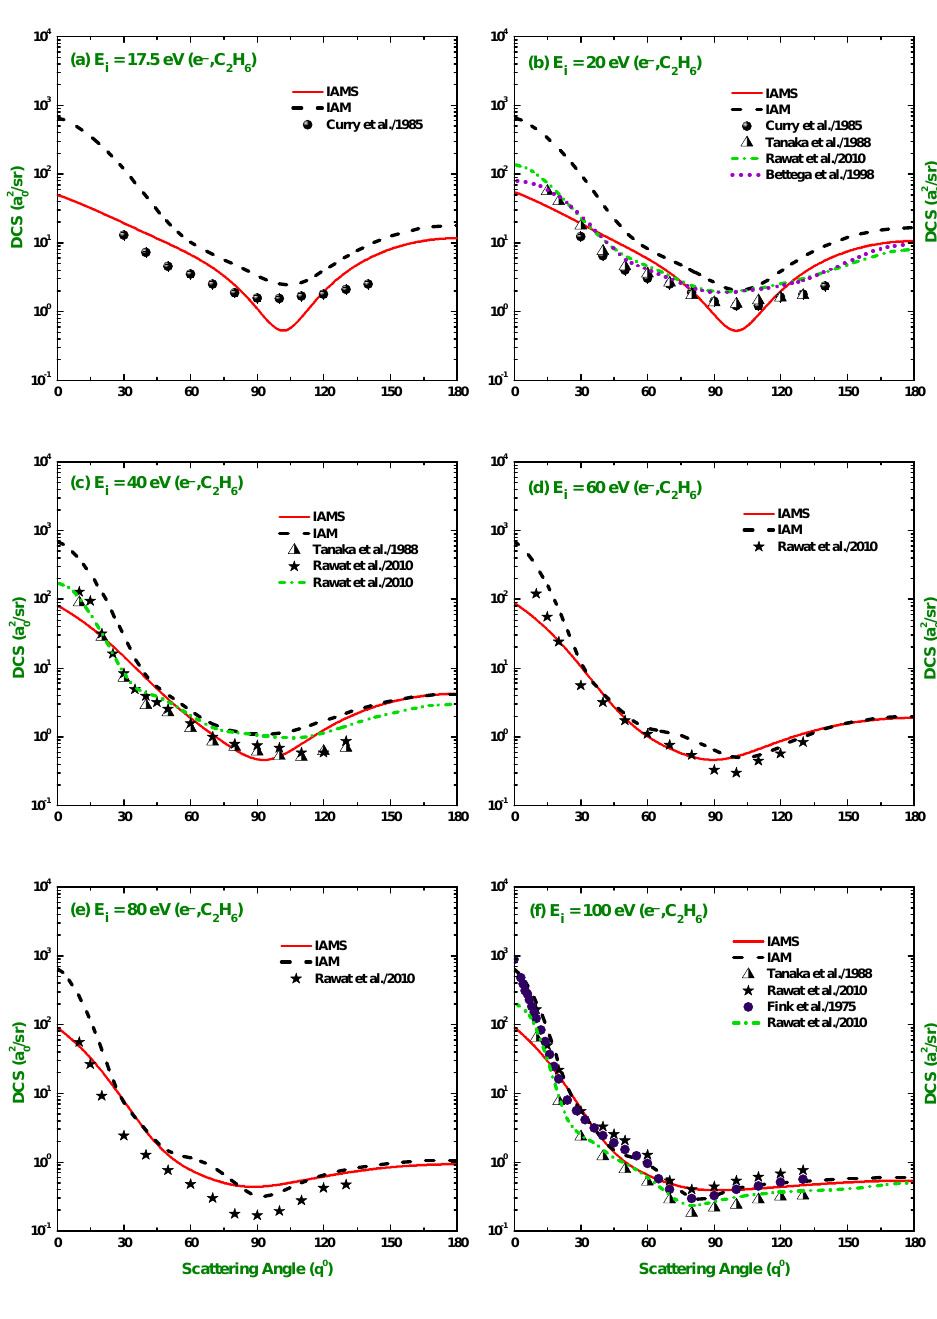
Figure 1. DCS ( a 2 / sr ) for the elastic scattering of electrons from C 2 H 6 at energies of 17.5, 20, 40, 60, 0 80, and 100 eV. Theoretical works: IAM, IAMS, Rawat et al. [23] and Bettega et al. [41]; Experimental works: Curry et al. [20], Tanaka et al. [22], Rawat et al. [23], and Fink et al.